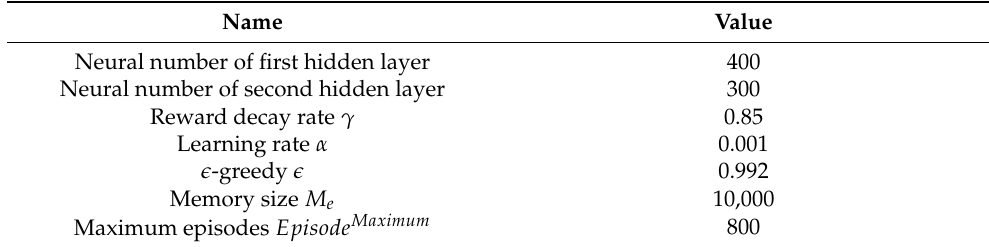
Table 1. Hyperparameters